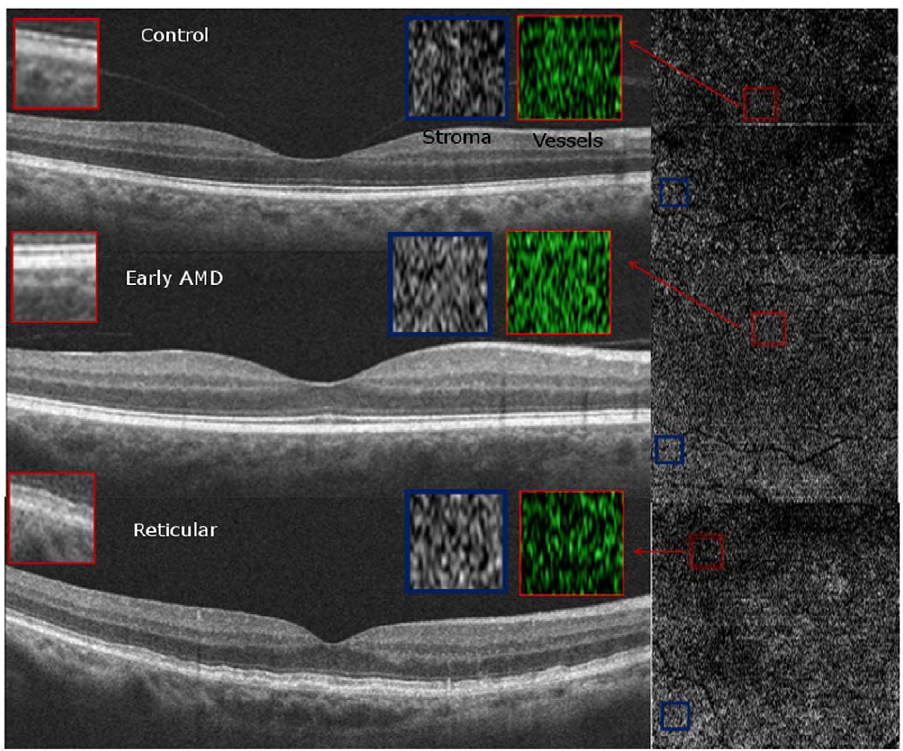
Figure 7. Qualitative Choriocapillaris Assessment Comparing C-Scans and B-Scans (Example 3). Comparisons of control (top panel), early age-related macular degeneration (AMD, middle panel) and reticular (bottom panel) patients reveals qualitatively different appearance of representative C-scans obtained just below the retinal pigment epithelium in reticular groups (bottom right) than in the control and AMD groups (top right and center right, respectively). Red boxes on the B-Scans (left) show magnified and colorized selected areas of choroidal vasculature from the regions contained by the smaller red boxes on the C-Scans (right) for each group. Blue boxes on the B-Scans (left) show magnified areas of selected stroma from the regions contained by the smaller blue boxes on the C-Scans (right). Stromal sections demonstrate more patchy whitish regions in the RPD group (bottom panel) as compared to the control and AMD groups (top and middle panels) but similar vessel density due to the presence of larger vessels.